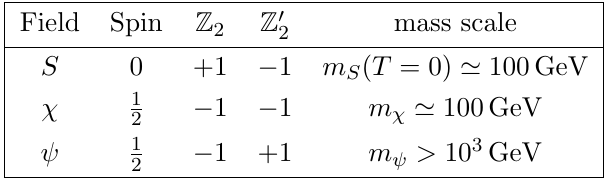
Table 3 . The new particle content in the mixing induced scenario. All (cid:12)elds are SM singlets.